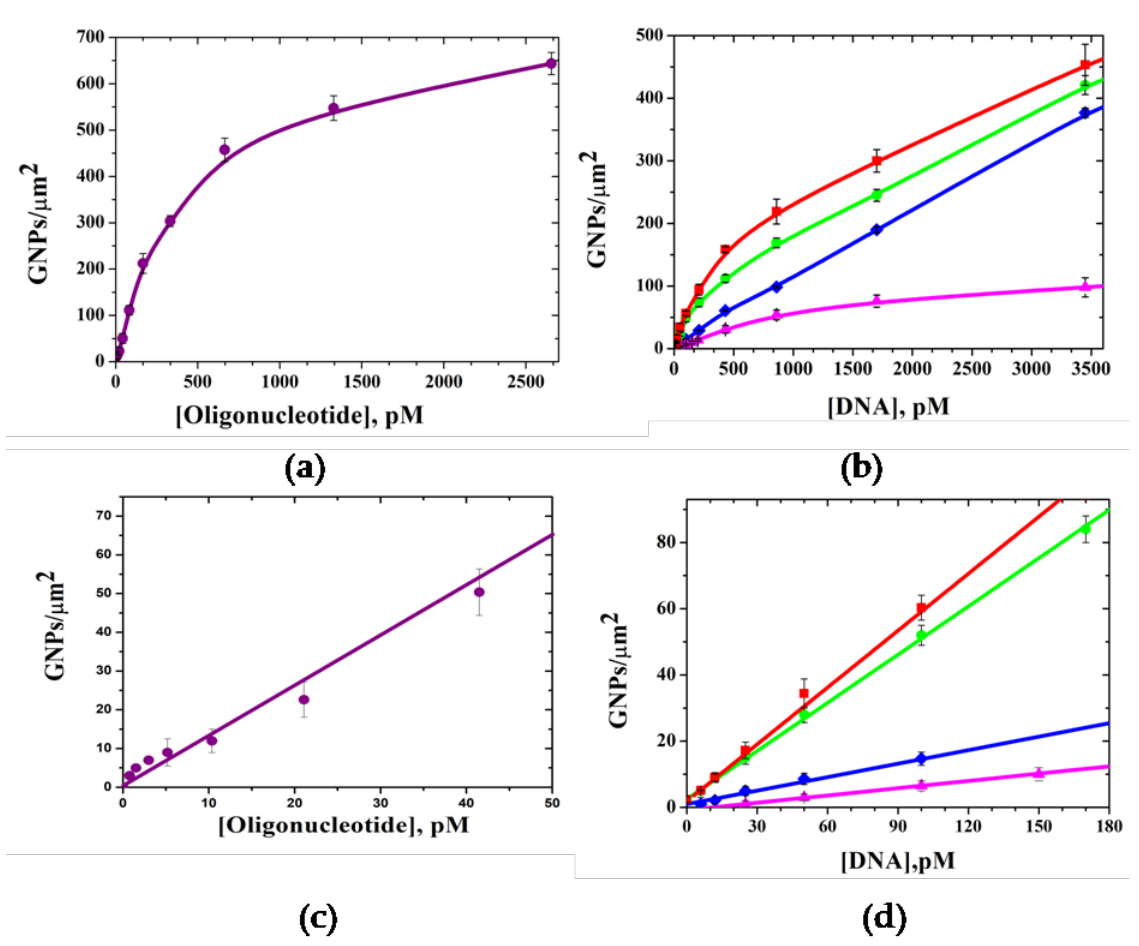
Figure 6. Calibration curves for the determination of short oligonucleotide Probe C ( a ) and long DNAs ( b ) containing blaTEM-1( ▲ ), blaCTX-M- 3(●), blaVIM-2 ( ♦ ), blaCTX-M-5 ( ■ ), on silicon microchips with digital detection. ( c , d ) — enlarged sections of the calibration curves ( a , b ) for low concentrations of target DNAs. Table 3. Analytical performances of different methods developed for quantitative determination of DNA.